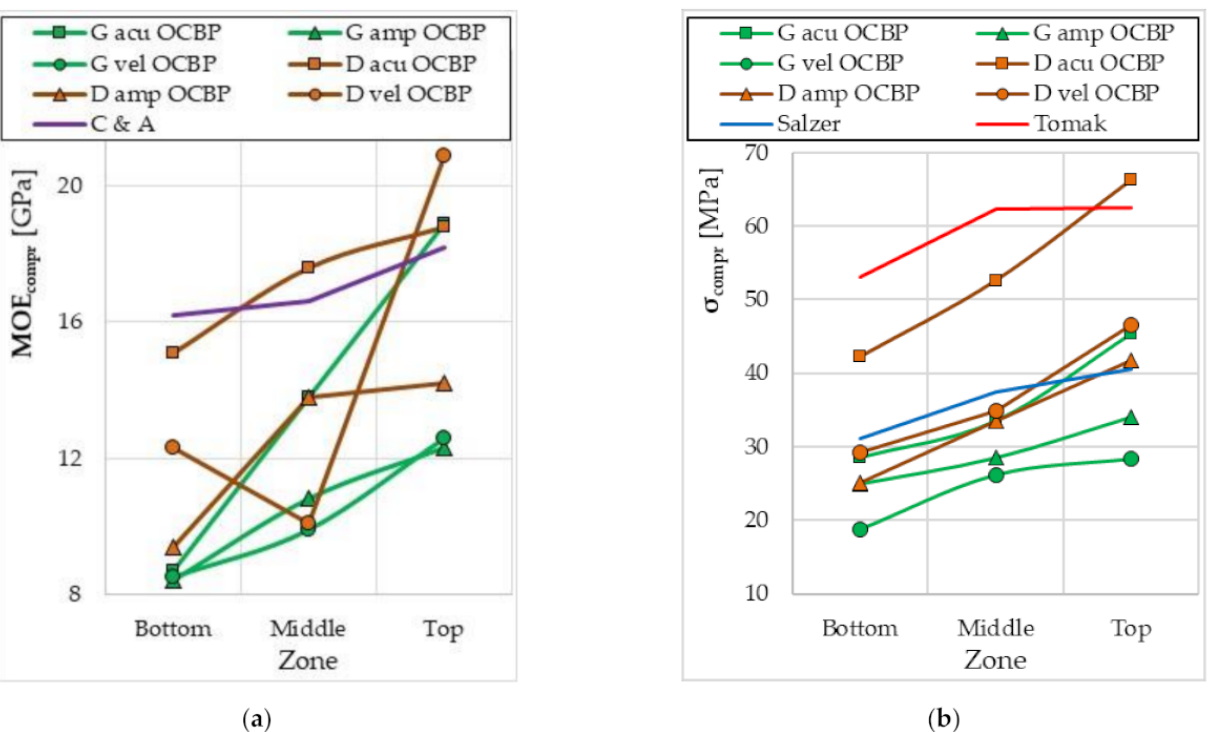
Figure 11. Changes in the values of biomechanical parameters depending on the bamboo shoot zone obtained in compression tests along the fiber: ( a ) modulus of elasticity in compression